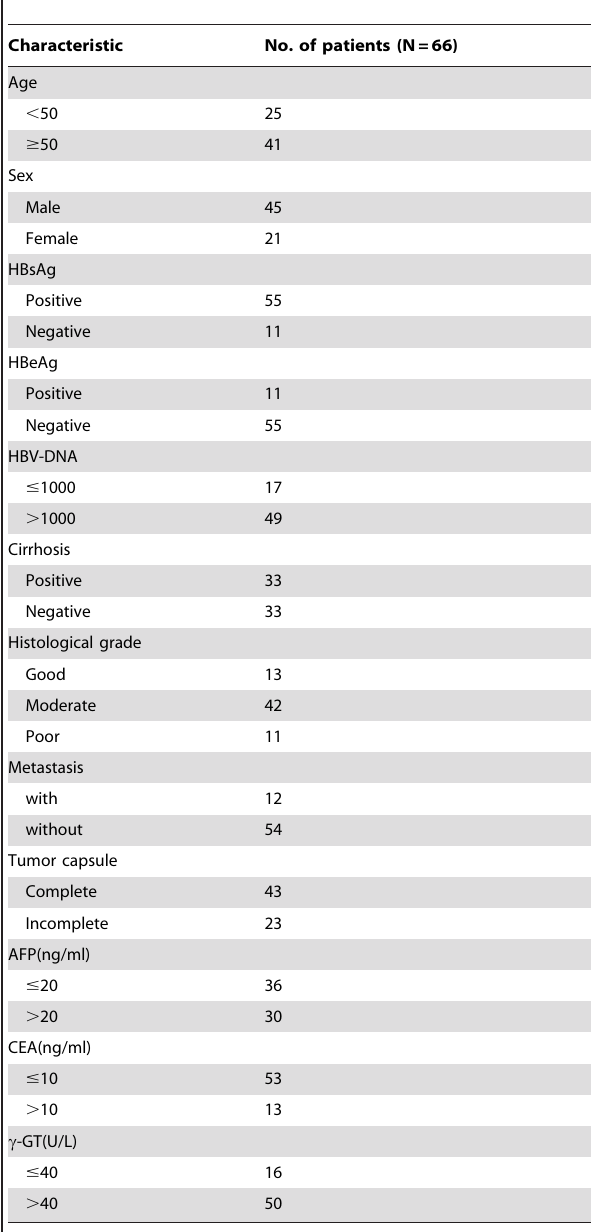
Table 1. Clinicopathological characteristics of patients with HBV-related hepatocellular